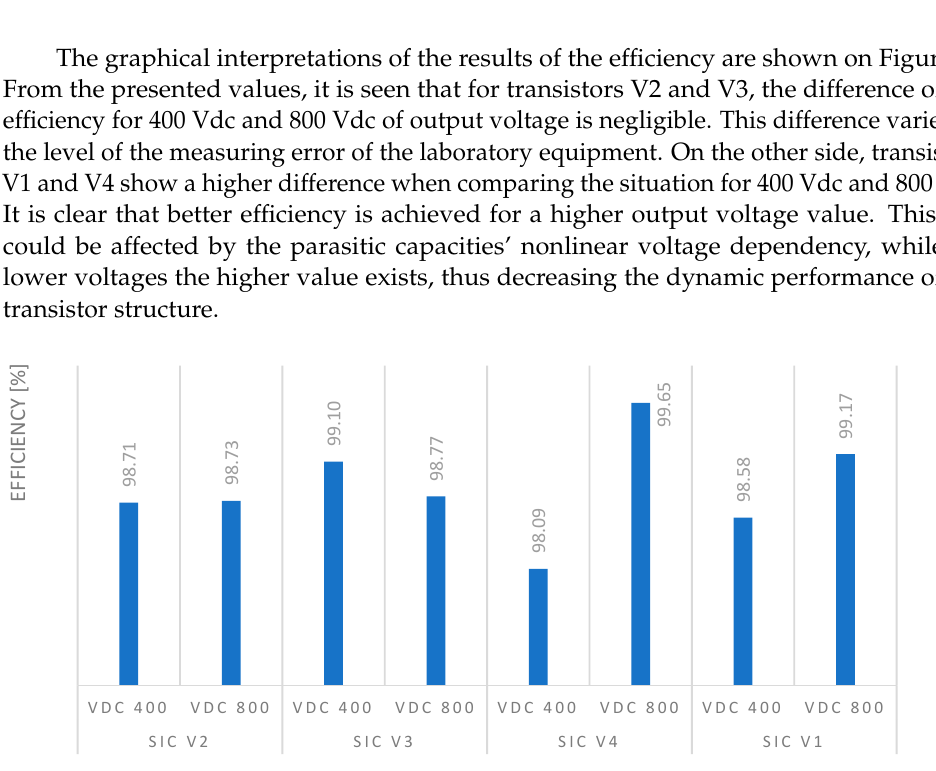
Figure 19. Evaluation of the efficiency performance for different dc link voltages and constant power delivery 3 kW.